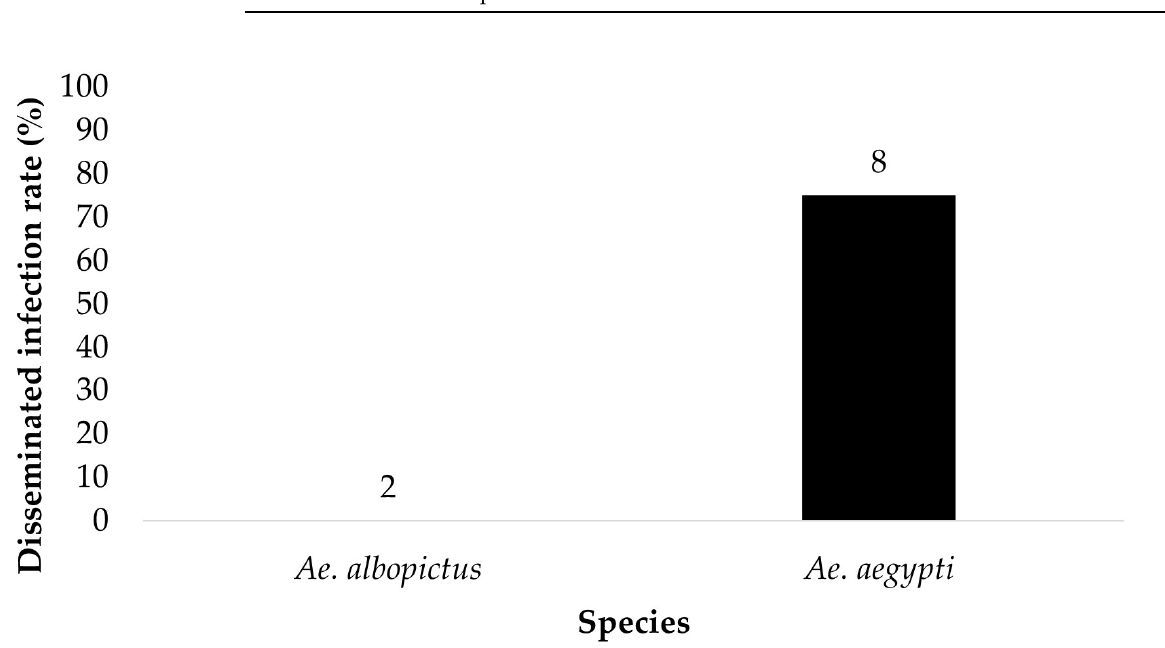
Figure 3. The legs of the ZIKV positive bodies (parents) were tested for the presence of ZIKV. The results show the disseminated infection of ZIKV in Ae. aegypti and Ae. albopictus from the treatment groups ingesting infected blood at a dose of 6 log 10 PFU/mL ZIKV. Numbers above the bars represent the number of mosquitoes tested.